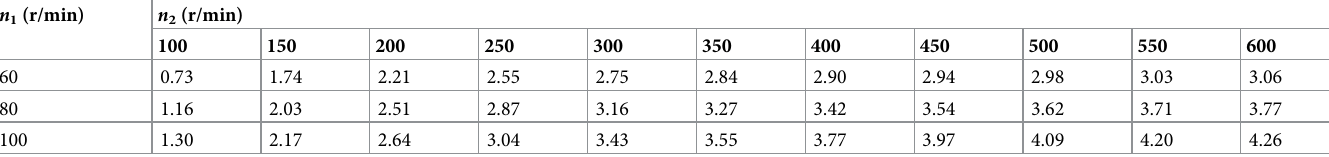
Table 4. Soybean productivity of scheme 1-3(t/h).